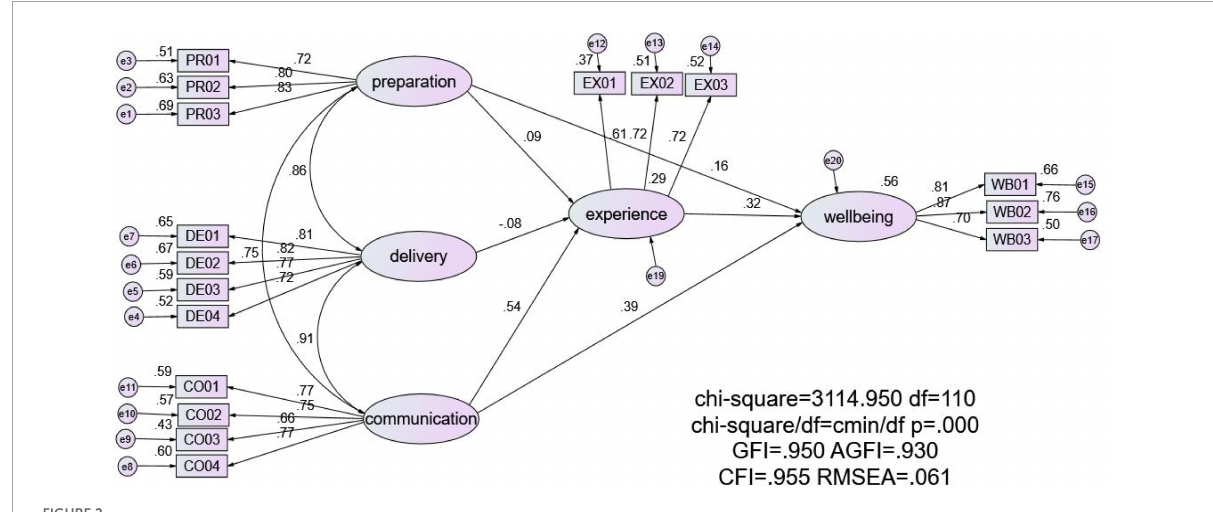
FIGURE2 Standardized structural relations among variables ( N =